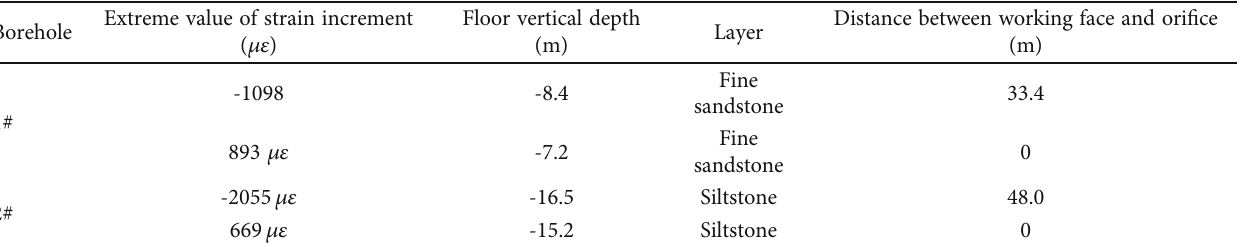
Table 3: Distributed fi ber strain maximum